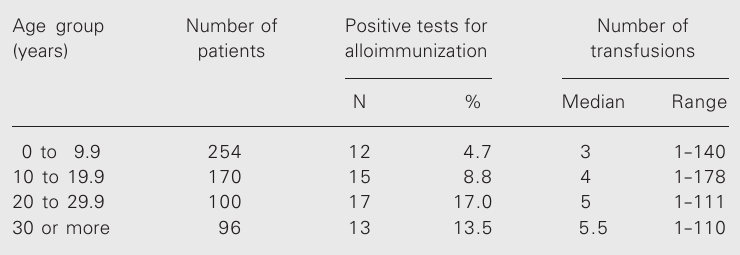
Table 3. Number of blood transfusions by age group and red blood cell alloimmuni- zation among 620 patients with sickle cell disease.